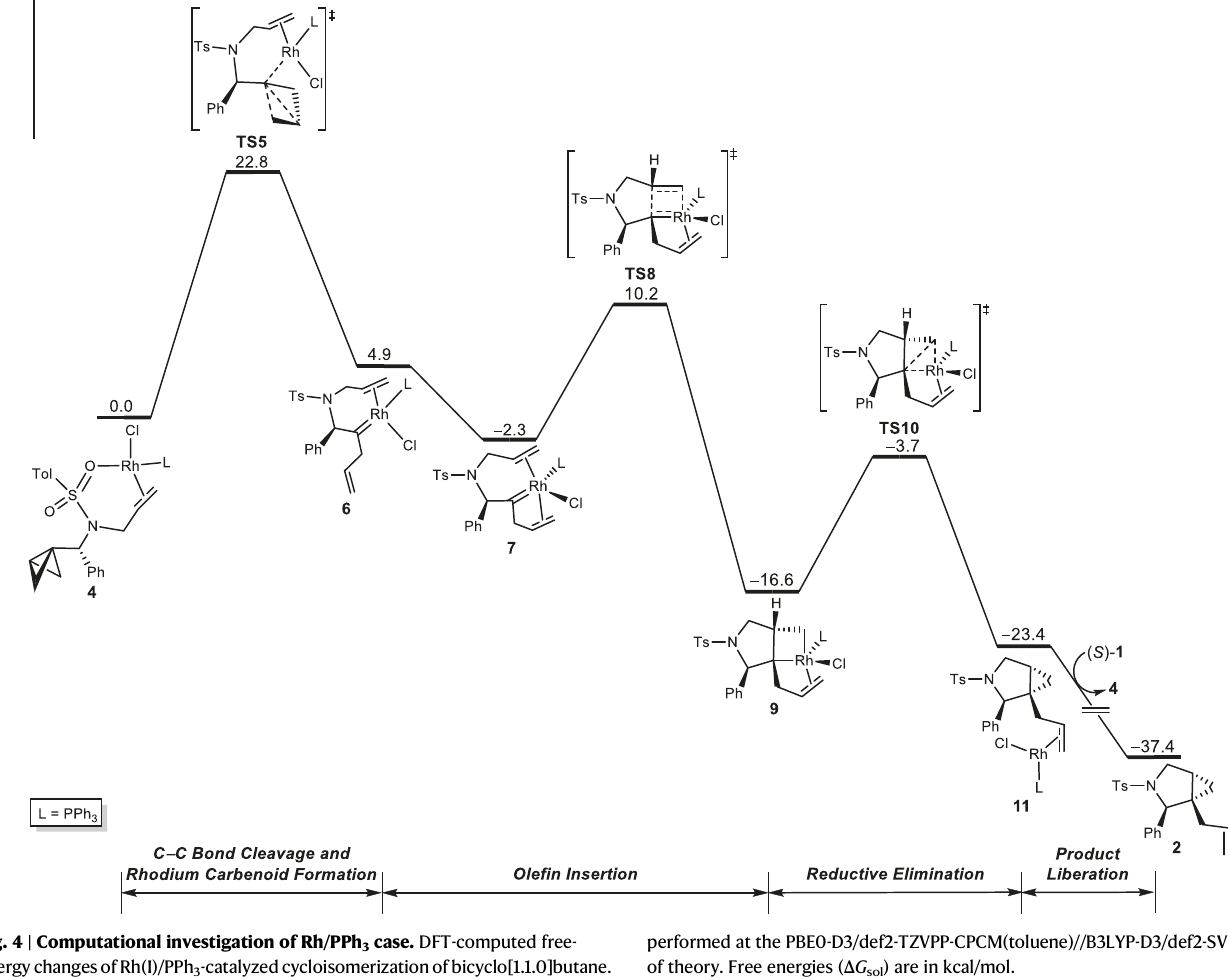
performed at the PBE0-D3/def2-TZVPP-CPCM(toluene)//B3LYP-D3/def2-SVP level of theory. Free energies ( Δ G sol ) are in